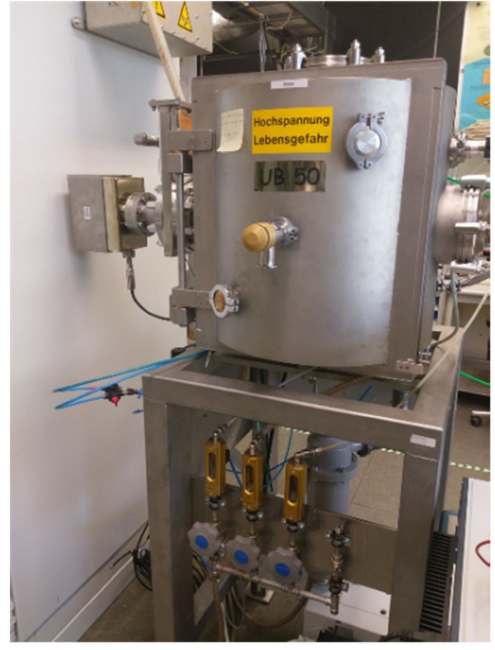
Figure 3. Morthymer vacuum